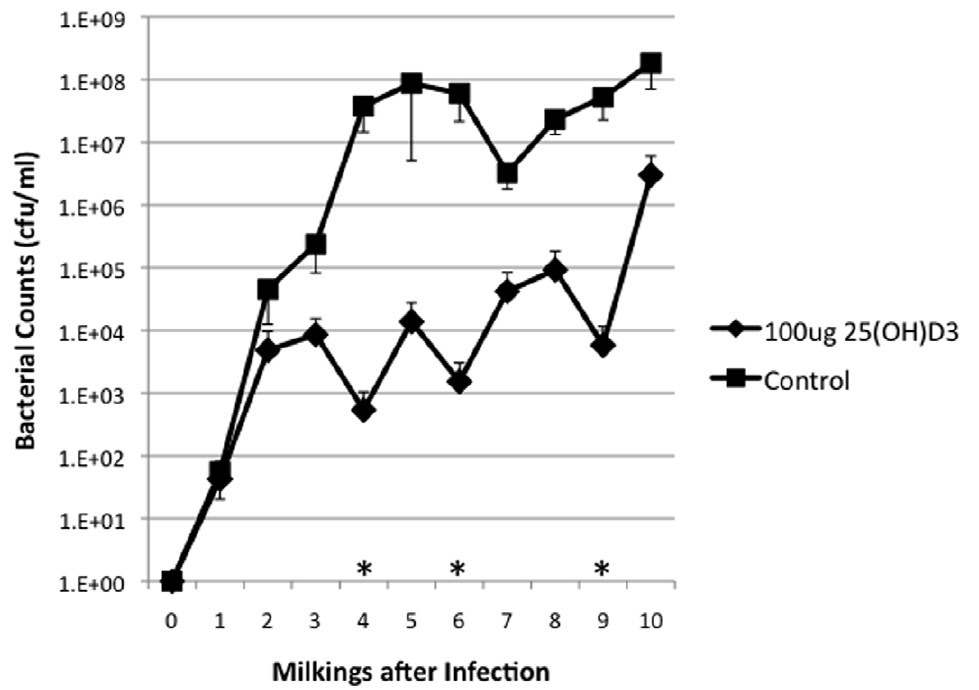
Figure 1. Bacterial Counts in Control and 25(OH)D 3 Treated Animals. Ten dairy cattle were infused with approximately 500 cfu of S. uberis in one quarter of their mammary gland. Five cows were immediately treated with 100 ug of 25(OH)D 3 in FBS and the remain five cows were treated with FBS alone. Cows were subsequently treated after each milking (twice daily) with 25(OH)D 3 or FBS for 10 milkings (5 days). Milk sample were isolated from each cow and serially diluted and plated on blood agar plates. Average bacterial counts were determined for 25(OH)D 3 treated ( u ) and control animals( n ). Time points with statistically significant differences are indicated with (*).